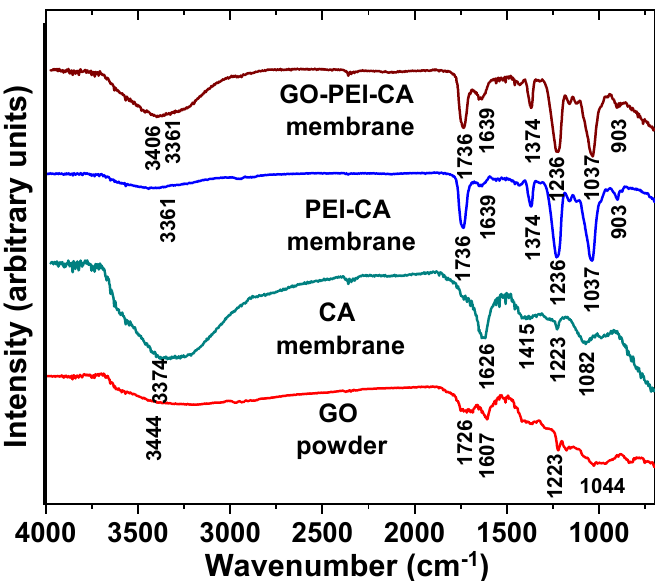
Figure 7. FTIR spectra of the graphene oxide powder, pristine cellulose acetate membrane, polyethyleneimine-soaked cellulose acetate membrane, and 2-bilayer GO–PEI-modified cellulose acetate membrane.